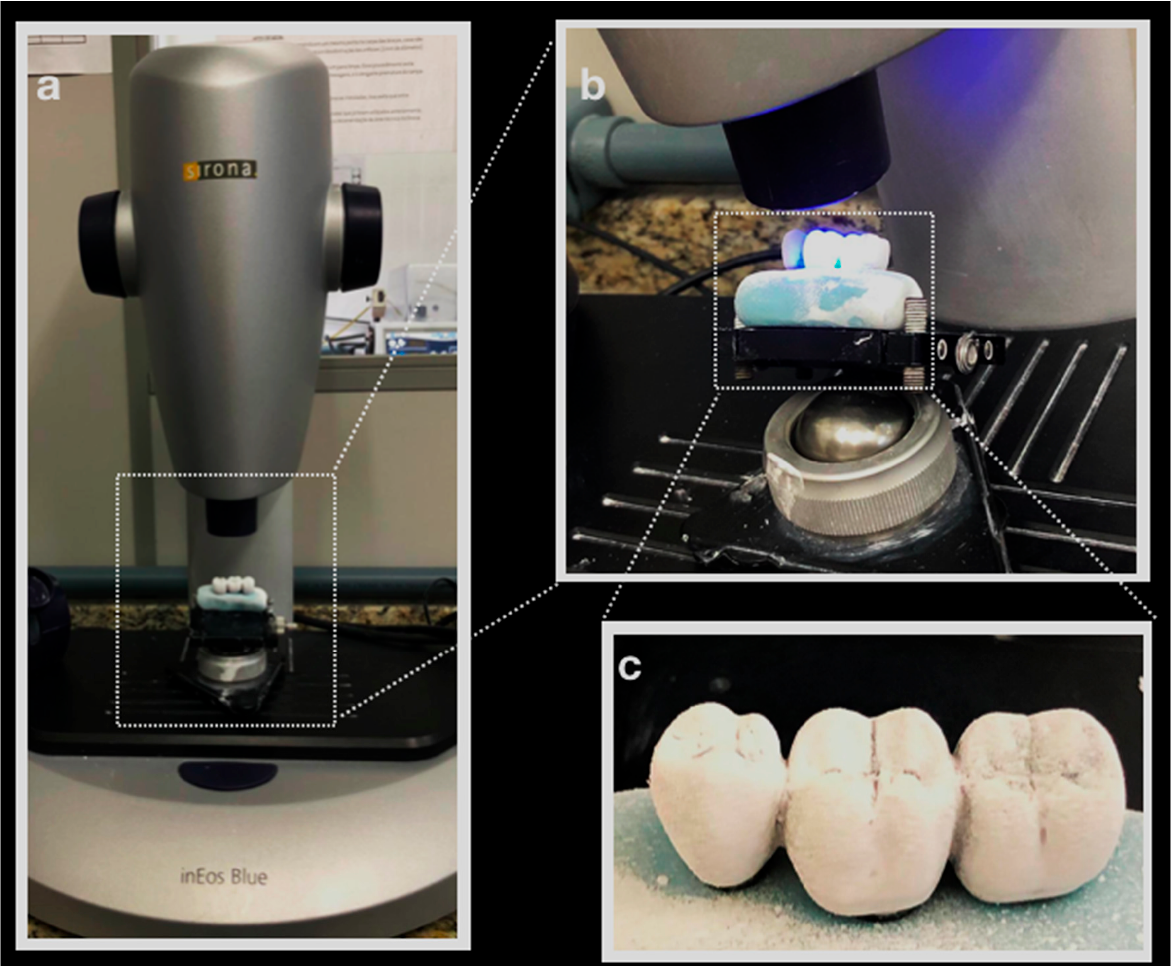
Figure 1. ( a ) Prosthesis on Sirona InEos Blue scanner base; ( b ) scanning; ( c ) silicone-based prosthesis